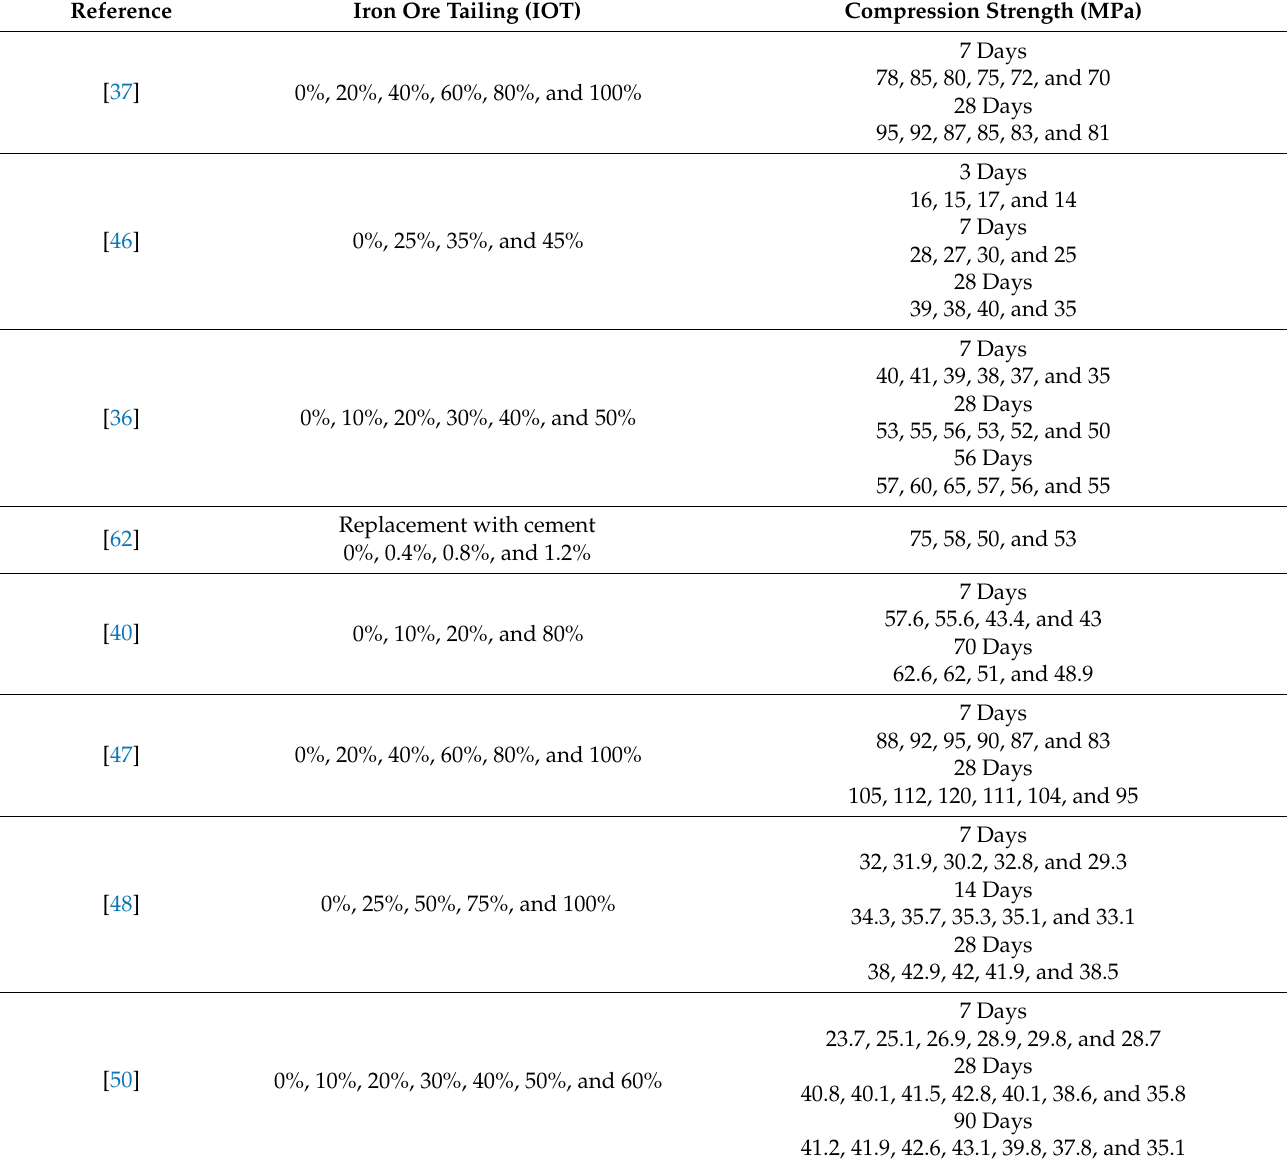
Table 3. Summary of compressive